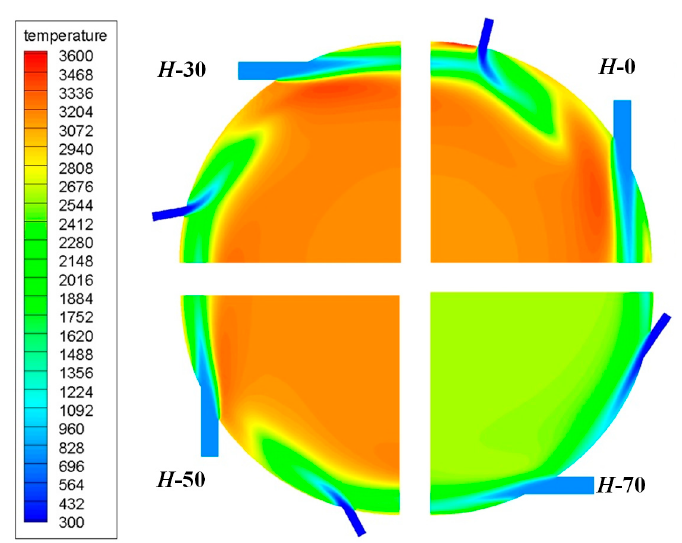
Figure 11. Velocity and H 2 O mass fraction distribution.